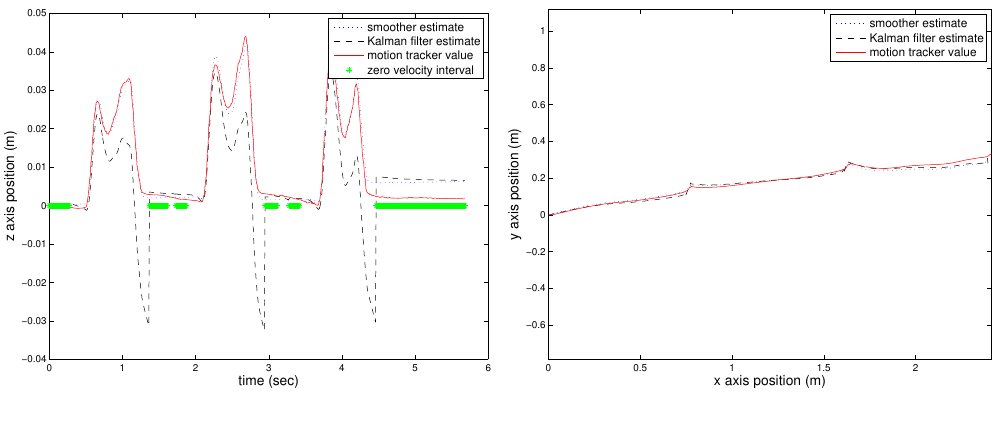
Figure 4. Estimated position without the flat floor assumption: z -axis position ( Left ) and xy -axis position ( Right